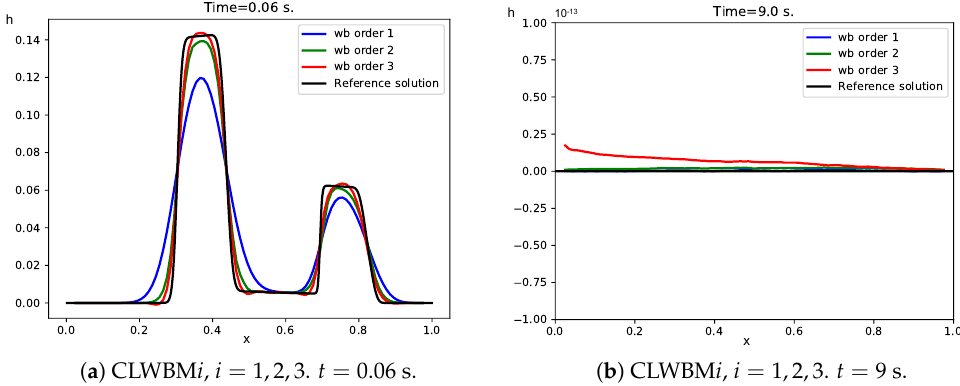
Figure 10. Test 4.2. Reference and numerical solutions: differences with the stationary solution for